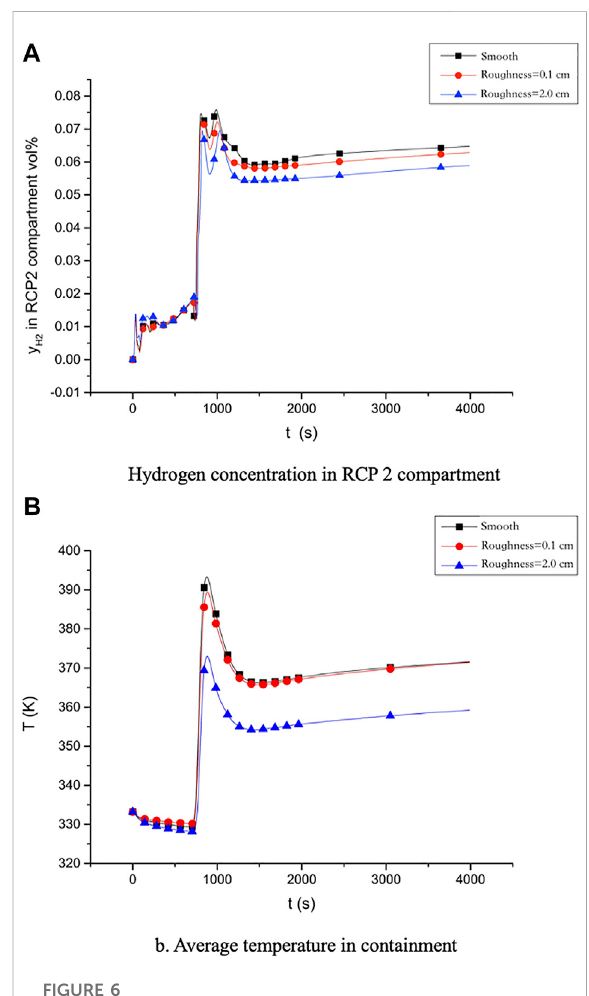
FIGURE 6 Hydrogen concentration and average temperature